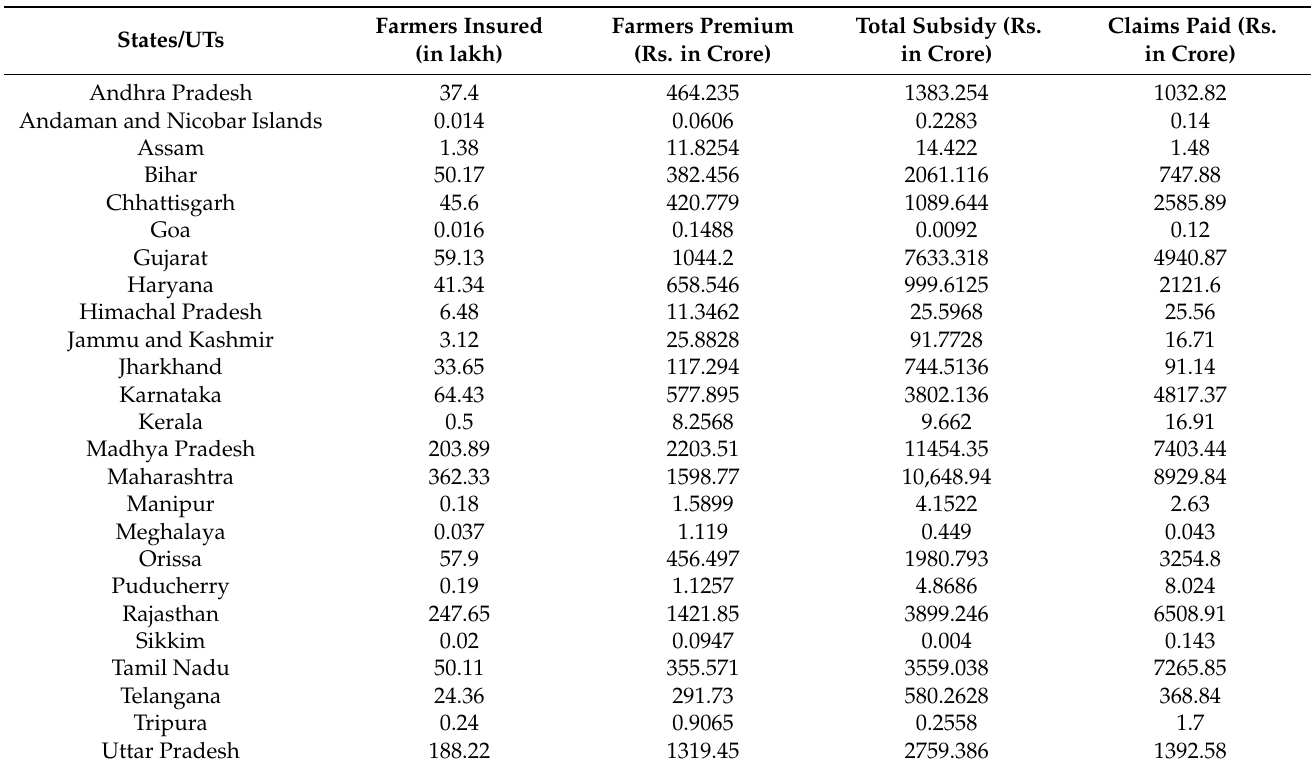
Table A6. State-wise performance of PMFBY—cumulative up to